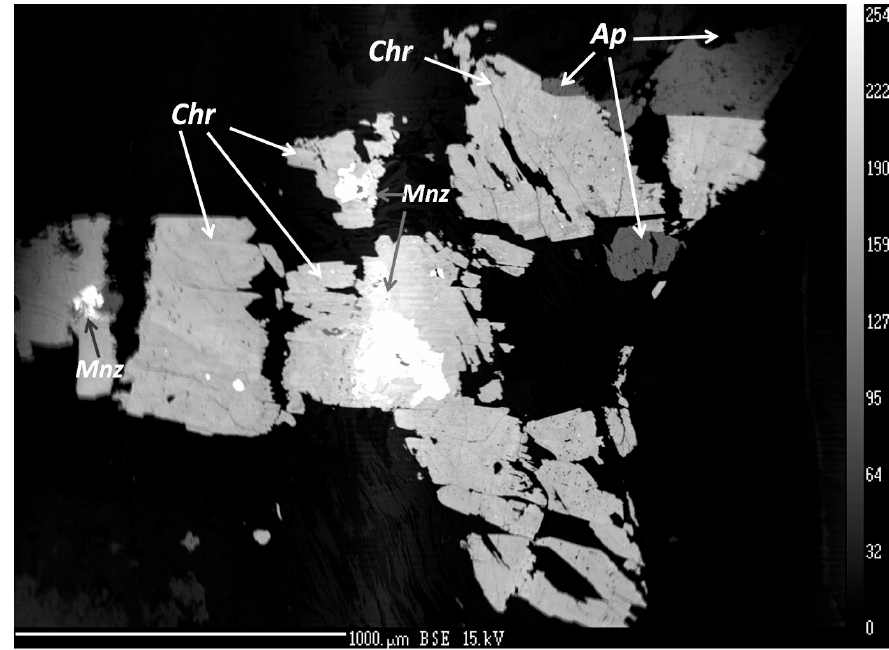
Figure 5. BSE image of churchite-(Y) (Chr), monazite-(Ce) (Mnz), and apatite group minerals (Ap) embedded in the plagioclase–muscovite–clinochlore matrix.